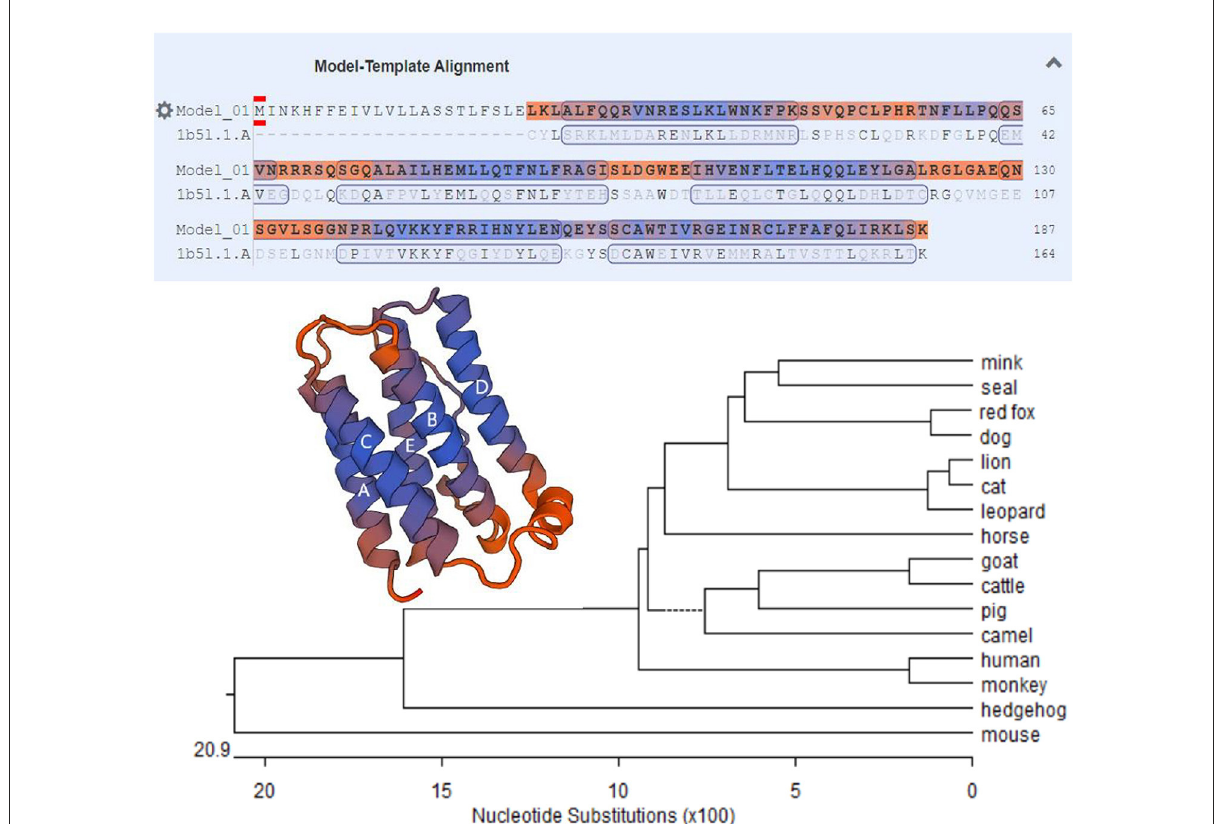
FIGURE2 Phylogenetic tree of MiIFN- ε amino acid sequences of several mammal interferons (IFNs). The bar scale represents the genetic distance. The credibility value for each node is shown. Predicted three-dimensional structures of MiIFN- ε established using Swiss-Model